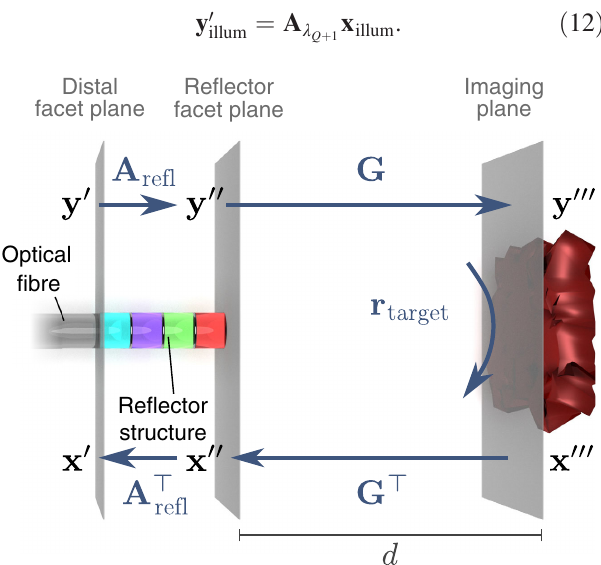
FIG. 2. Physical model used for fiber imaging. Vectors at the distal facet are denoted using the prime symbol ( 0 ), vectors at the exit facet of the reflector stack are denoted with double prime ( 00 ), and vectors at the imaging plane are denoted with triple prime ( 000 ). Here, A represents the TM of the reflector stack, G is a refl free-space propagation operator (e.g., Fresnel diffraction para- metrized by the distance d between the reflector structure and the imaging plane), and r is the reflectance profile of the target